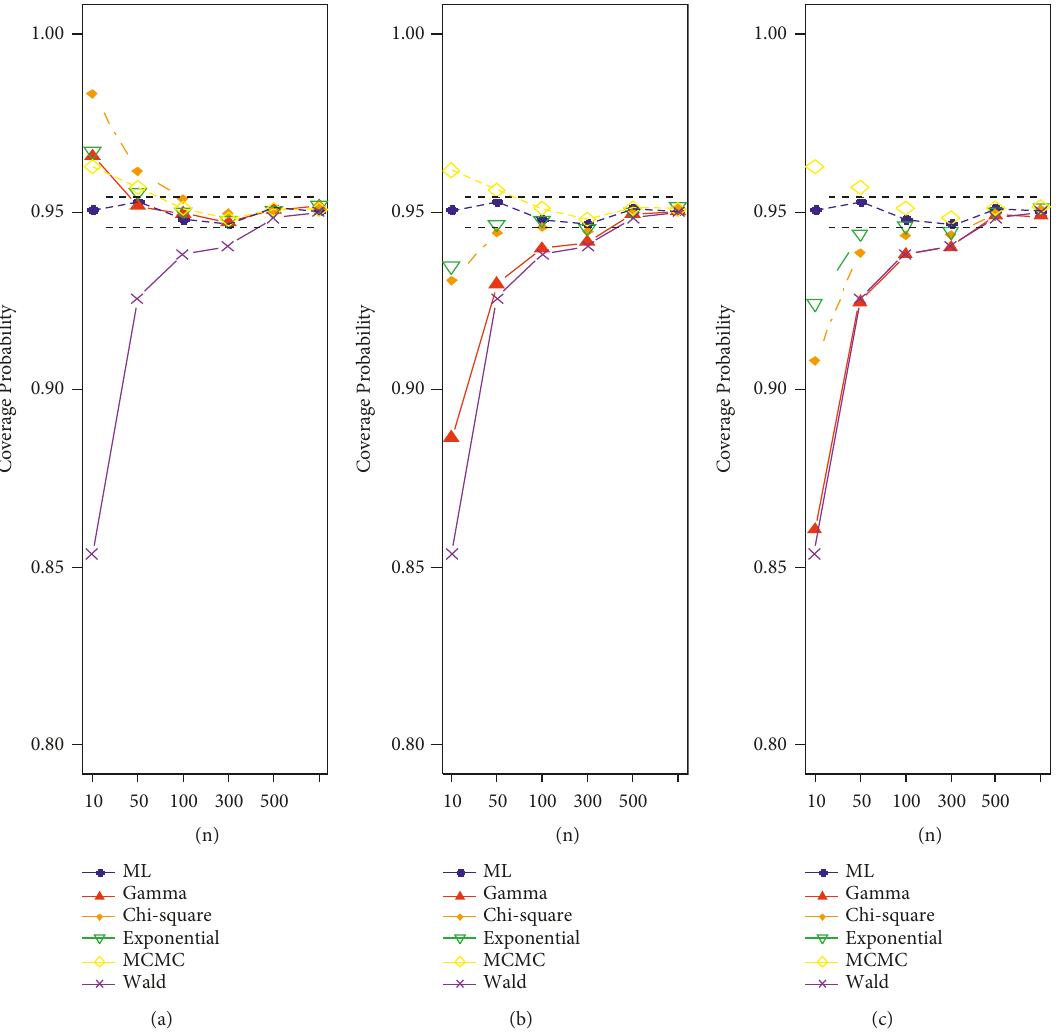
Figure 5: The trend of CP for all methods varies by the sample sizes at 95% confidence interval. (a) Variance � 2. (b) Variance � 4. (c) Variance �